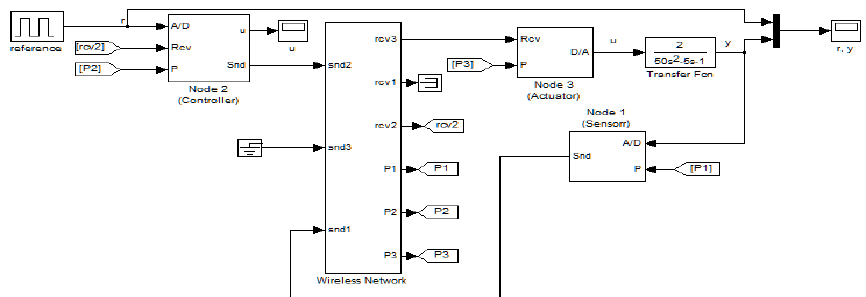
Figure 5. The structure of the IEEE 802.11b network.